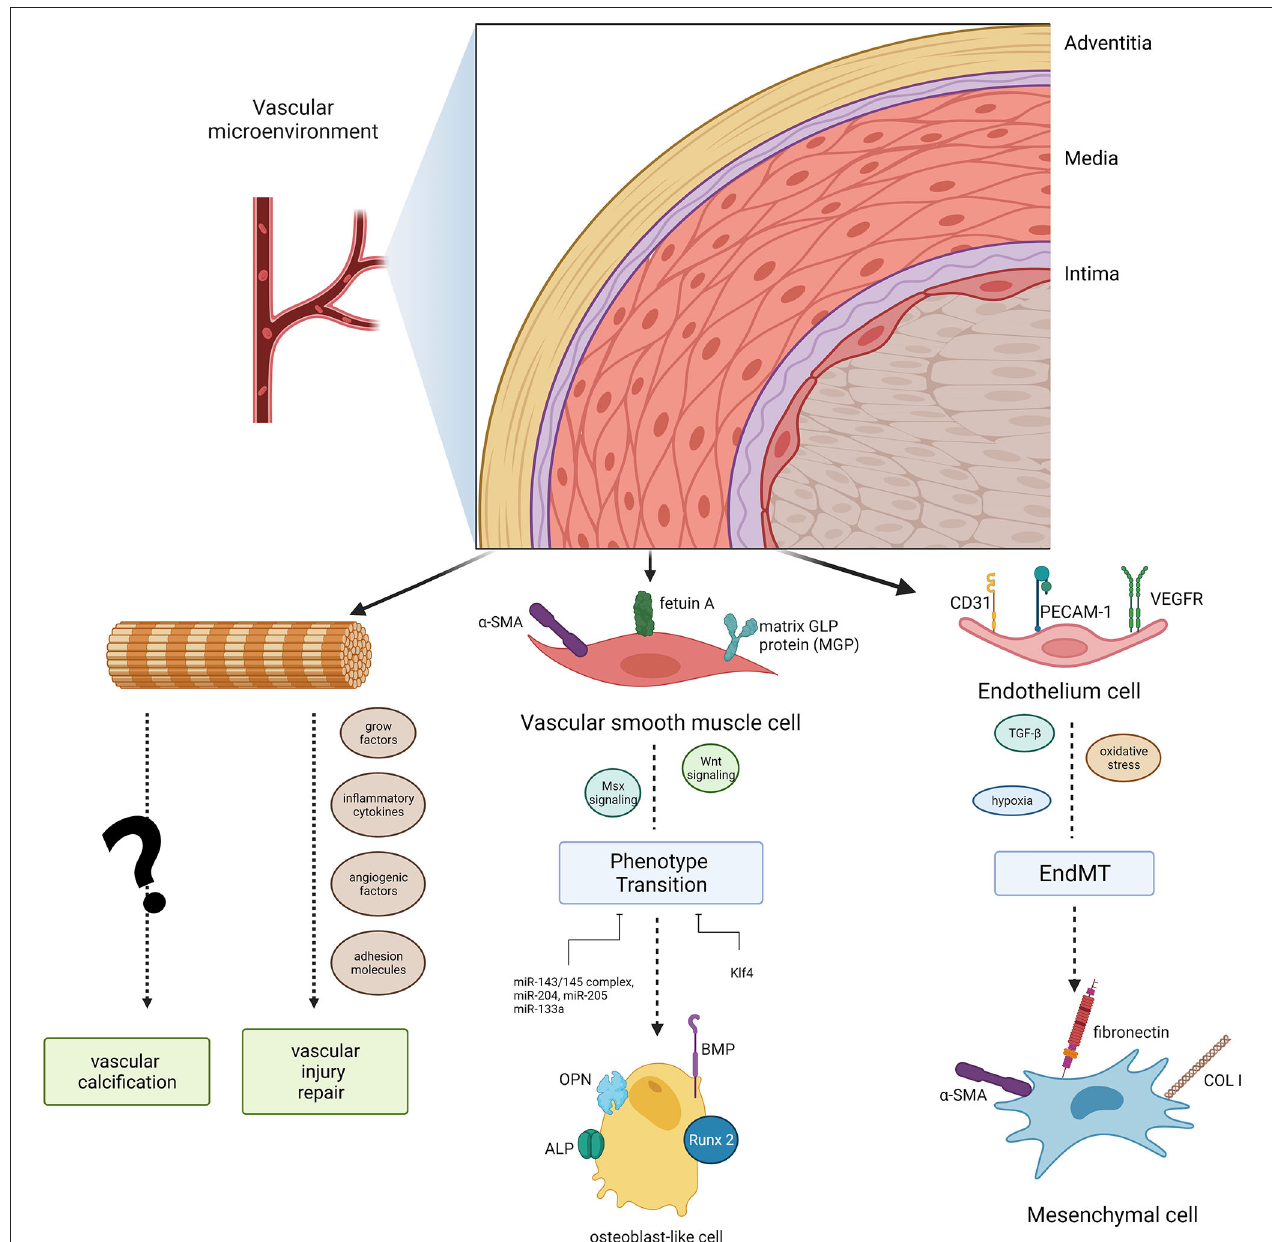
FIGURE 1 | Diagram of the cell populations in the vascular microenvironment and their roles in vascular calcification. Endothelial cells (ECs) and vascular smooth muscle cells (VSMCs) can induce phenotype transitions (EndMT, endothelial- mesenchymal transitions, a specific transition of ECs) in the microvasculature mineralization process via several signaling pathways. Adventitial fibroblasts could function in vascular calcification as well as vascular injury repair.